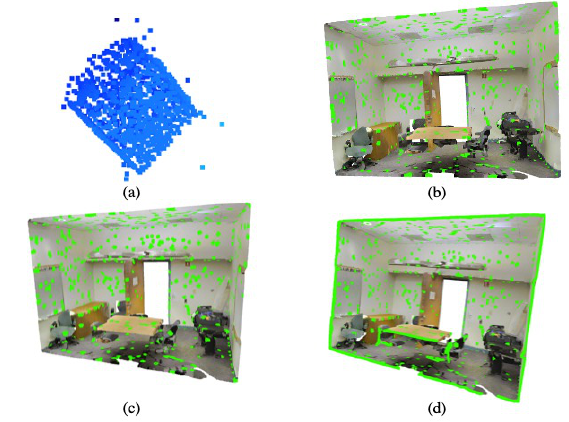
Figure 4. The group of neighbourhood points are selected from the point clouds around the key points. (a) Key points (b) Adaptive neighbourhood selection. (c) KNN neighbourhood selection. (d) Radius neighbourhood selection.